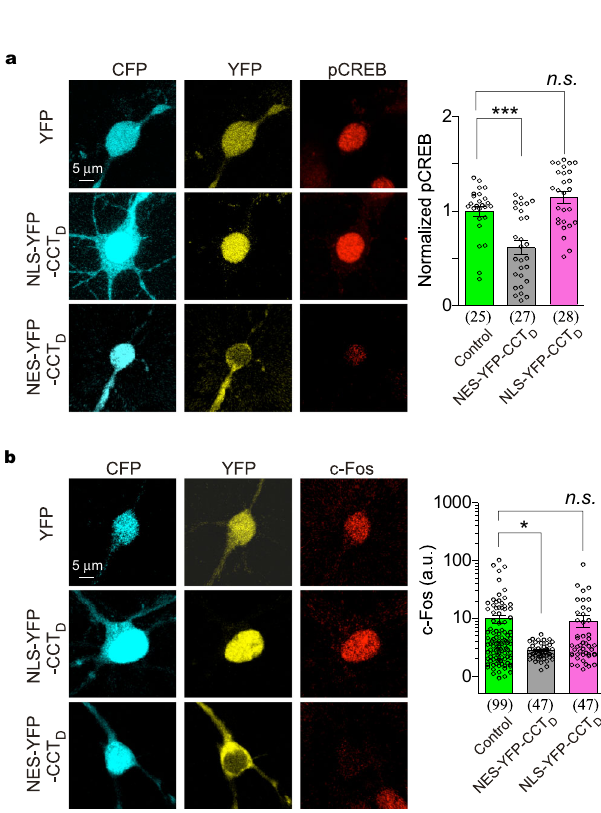
Fig. 6 Effects of Ca V 1.3-encoded peptides on neuritogenesis signaling in cortical neurons. a , b Inhibitory effects on pCREB and c-Fos by cytosolic peptides of exogenous CCT D . Confocal fl uorescence images of cortical neurons expressing YFP, NLS-YFP-CCT D or NES-YFP-CCT D . YFP indicates CCT D distribution, and CFP illustrates cell bodies, respectively. Normalized pCREB ( a ) and c-Fos fl uorescence ( b ) in the nuclei are summarized and compared. One-way ANOVA followed by Dunnett for post hoc test ( a ), and Kruskal-Wallis and Dunn ’ s non-parametric test ( b , non-normal distribution, checked by D ’ Agostino & Pearson omnibus normality test) (* p < 0.05; *** p < 0.001; n.s . denotes not signi fi cant, p > 0.05). Values are represented as mean ±